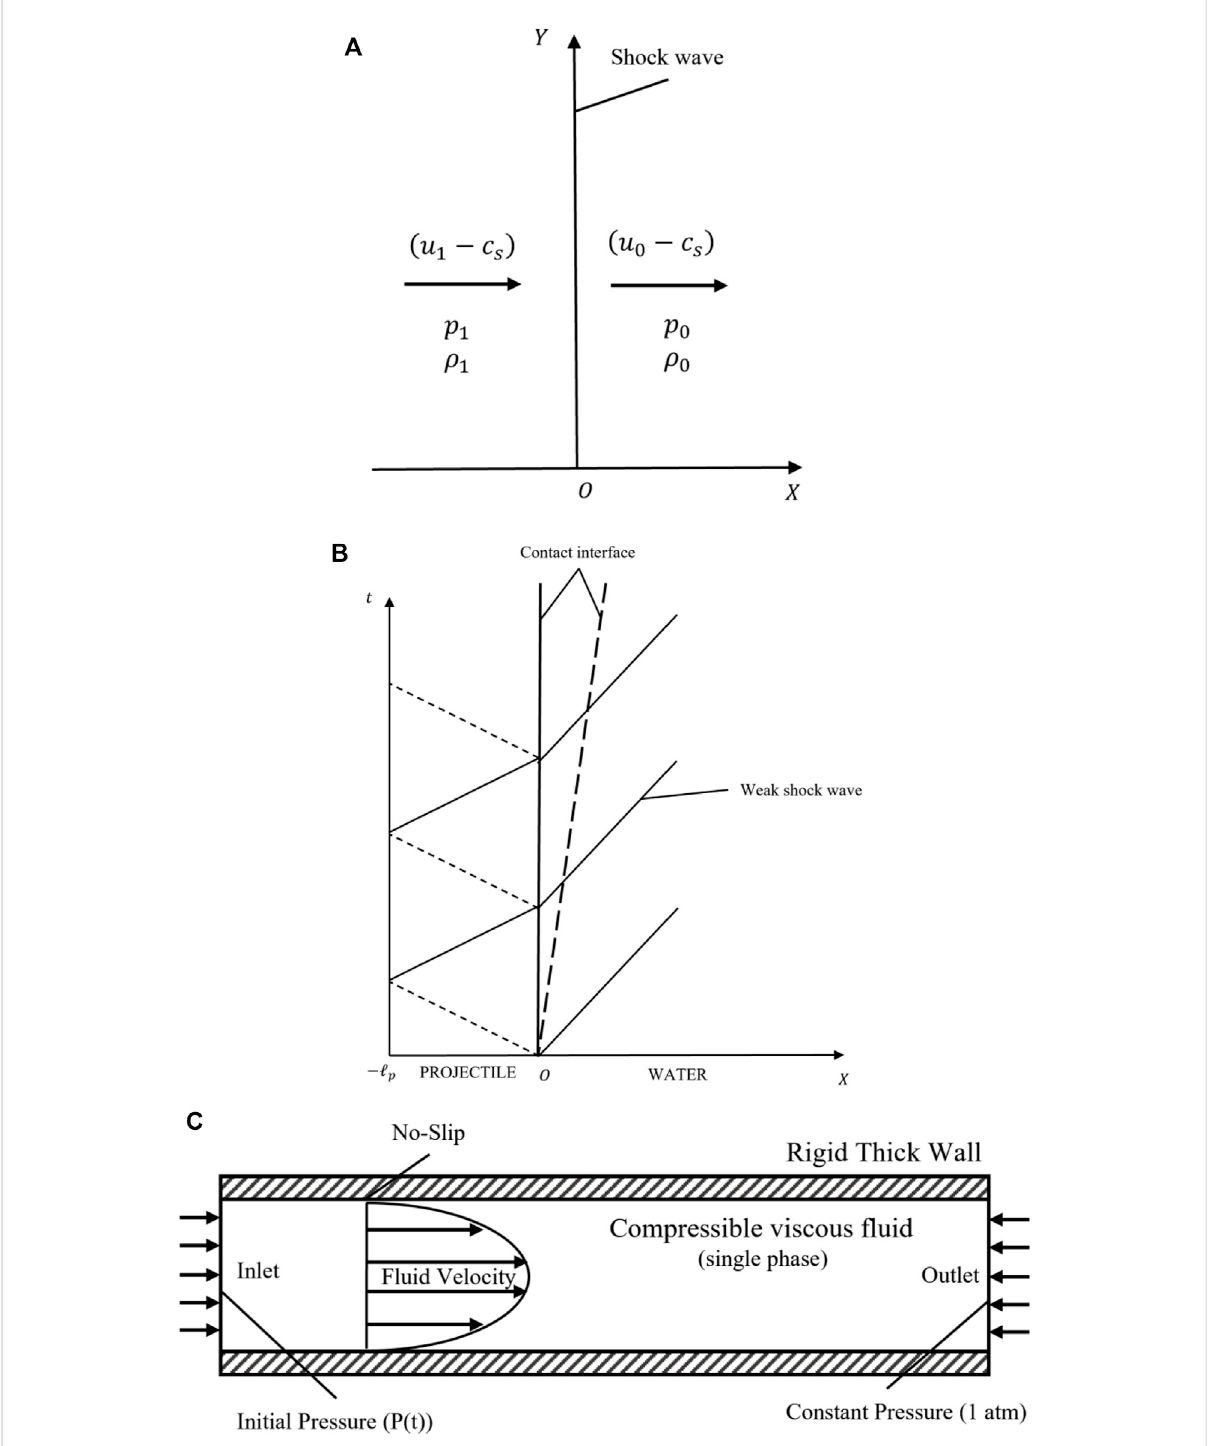
FIGURE 2 The isolation of boundary conditions and analysis of the model. (A) The weak shock wave jumps conditions under a coordinate fi xed with the shock wave front; (B) The weak shock wave generated by projectile impact analysis; (C) A schematic diagram illustrating the micro-channel boundary conditions in CFD